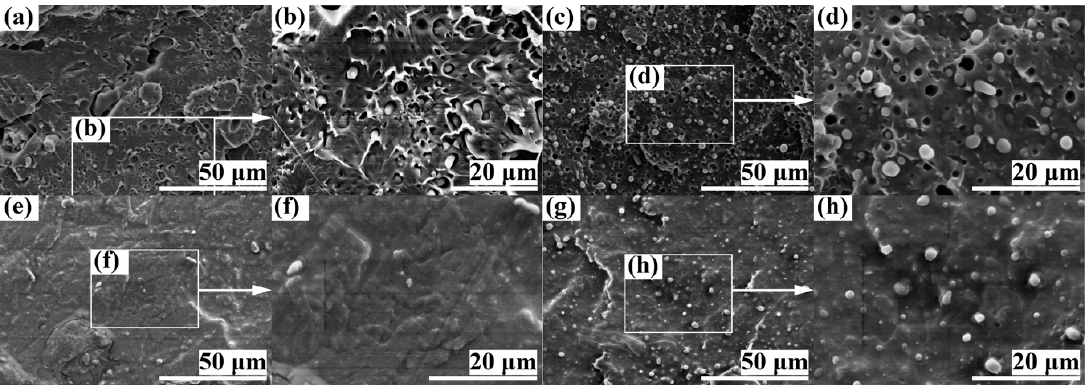
Figure 1. Scanning electron microscopy (SEM) micrographs of the impact-fractured surfaces of polylactide (PLA) / polystyrene- b -polybutadiene- b -polystyrene (SBS) (95 / 5 w / w) blends ( a – d ) uncompatibilized and ( e – h ) compatibilized with 1.0 wt % poly(styrene- ran -methyl acrylate) (S-MA). Images ( a ), ( b ), ( e ), and ( f ) represent the surface topography in the “skin” of a typical injection-molded Charpy notched impact specimen; images ( b ) and ( f ) are magnifications of images ( a ) and ( e ), respectively; images ( c ), ( d ), ( g ), and ( h ) show the surface topography in the “core” of the same specimen; images ( d ) and ( h ) are magnifications of images ( c ) and ( g ), respectively.